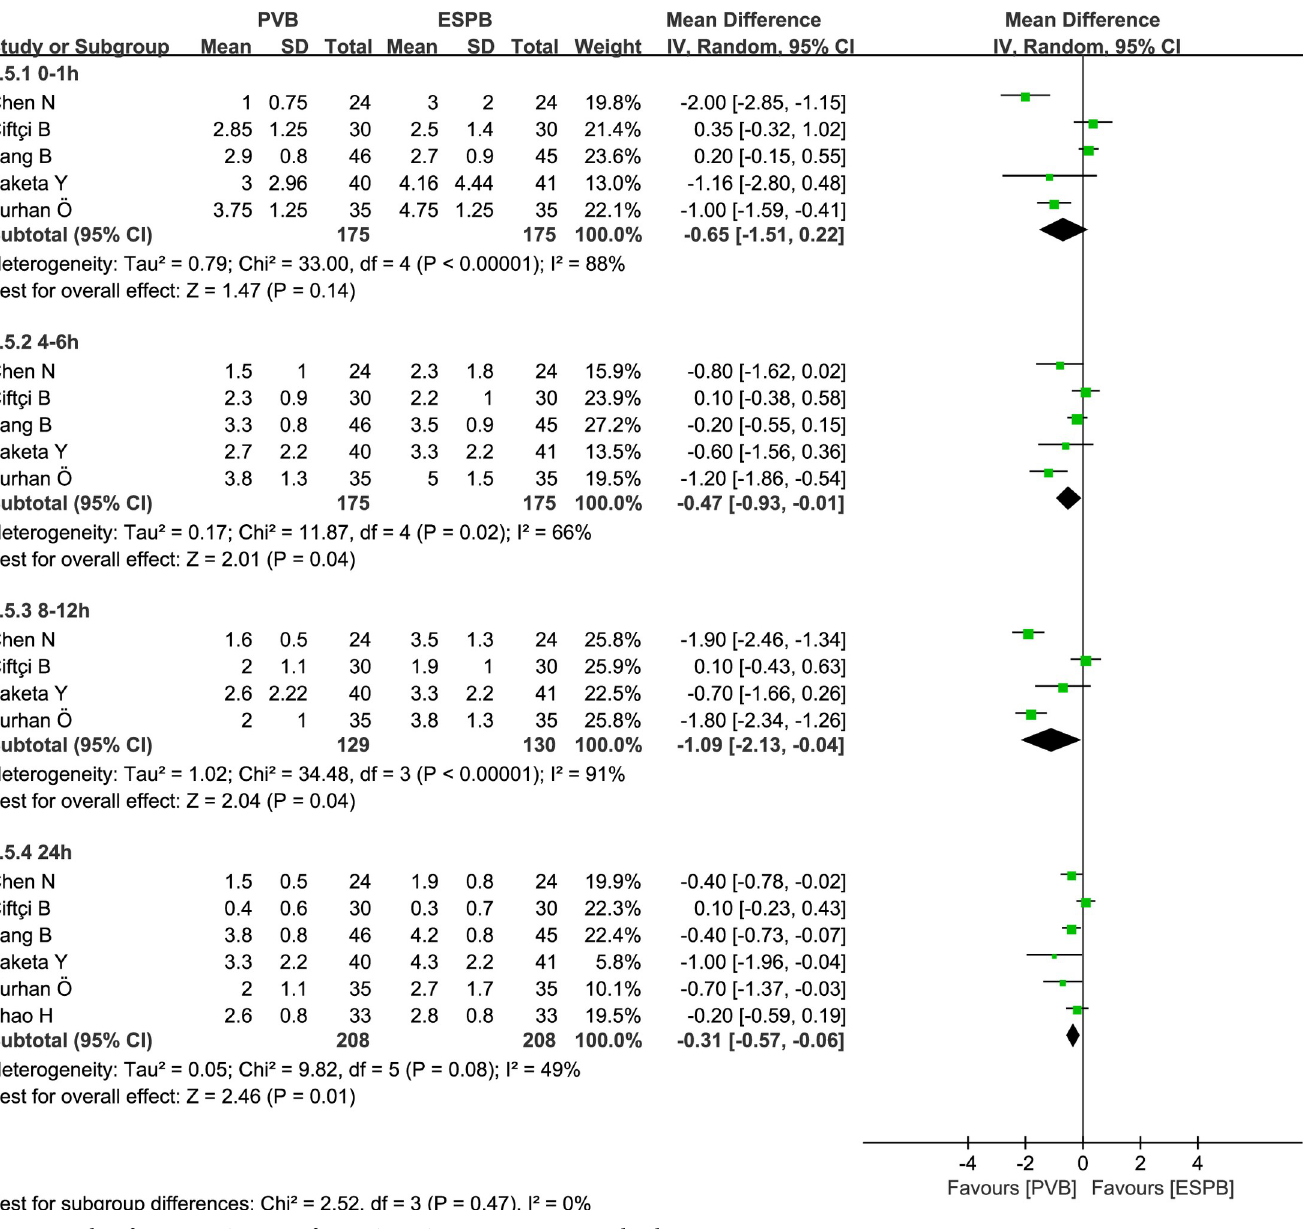
PLOS ONE | https://doi.org/10.1371/journal.pone.0256611 August 25,